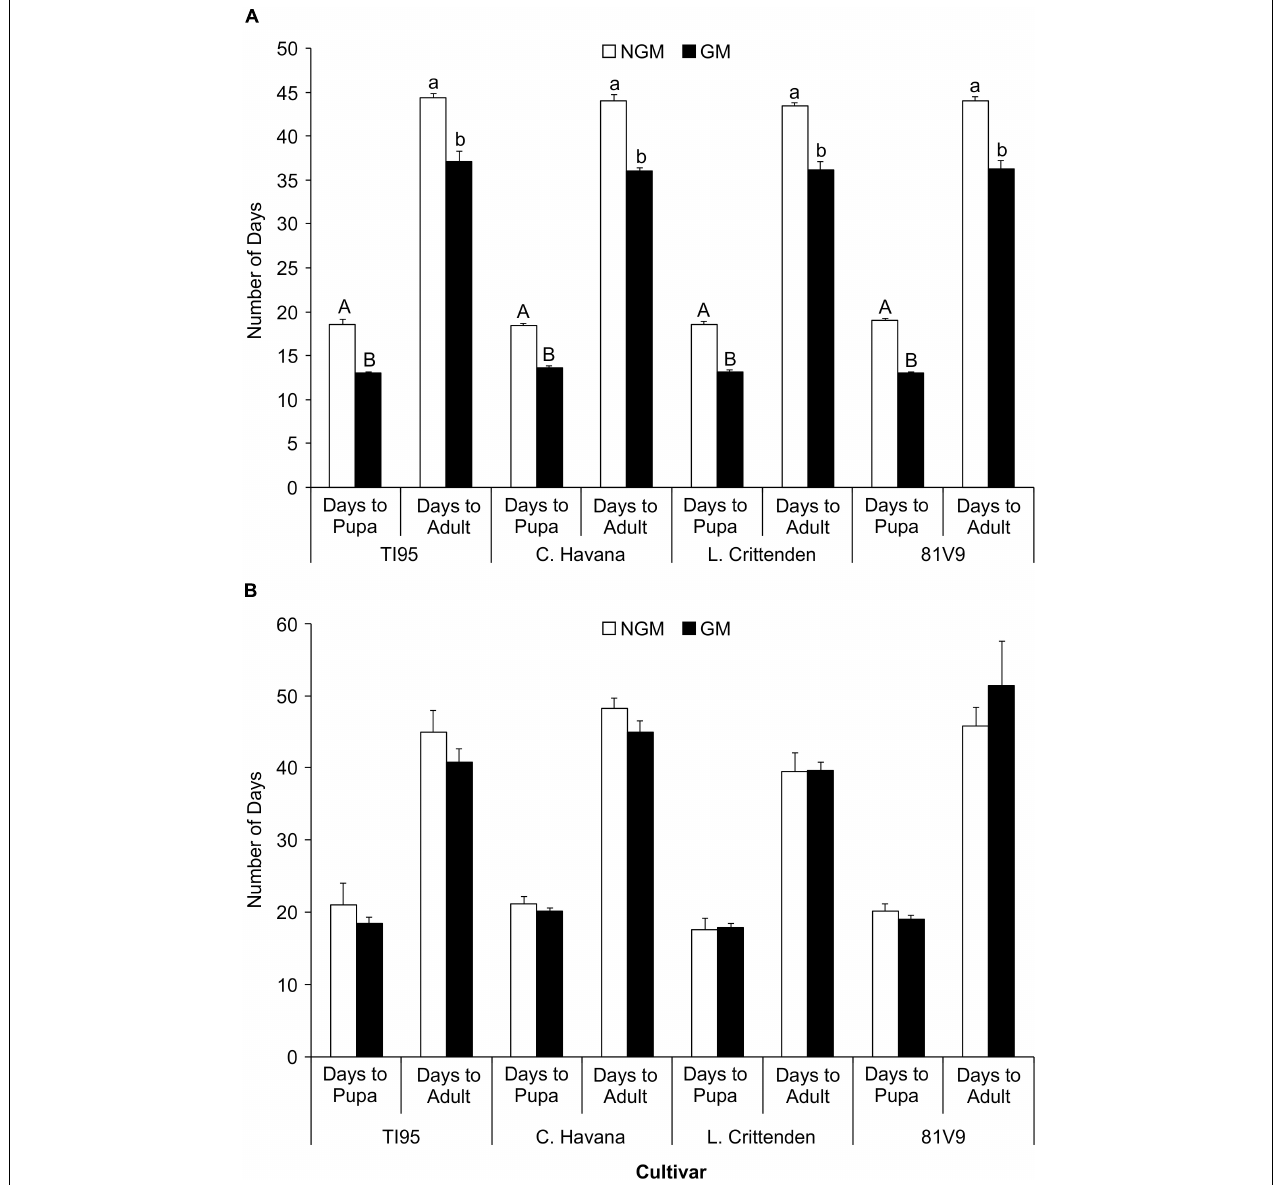
FIGURE 3 | Tobacco hornworm develop faster on transgenic cultivars in the greenhouse, but not in the field. The mean number of days to pupa and to adult stage ± S.E. for tobacco hornworm. (A) greenhouse-grown ( N = 20/cultivar) and (B) field-grown plants ( N = 20/cultivar). Cultivars with the same uppercase (days to pupa) or lowercase (days to adult) letter in (A) are not statistically different, no letters in (B) indicates no statistical difference among all treatments (2-way ANOVA, Tukey’s pairwise comparison, P <